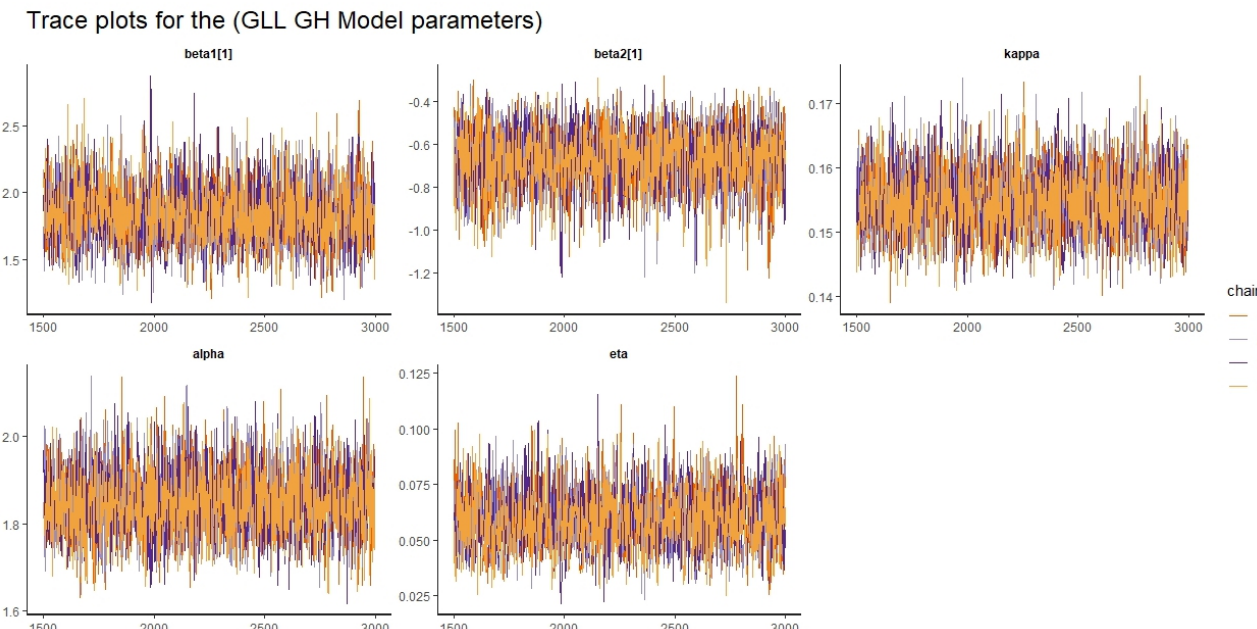
Figure 6. Trace plots for the GLL − AM model parameters.